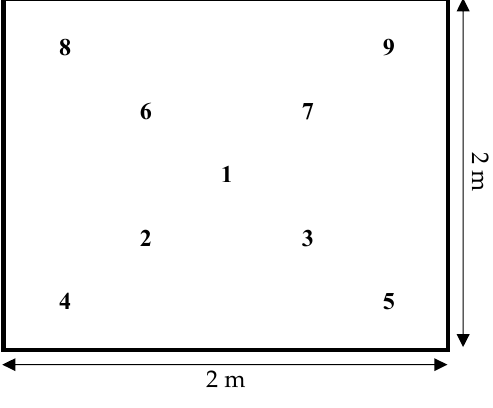
Figure 1. Scheme of experimental plot.